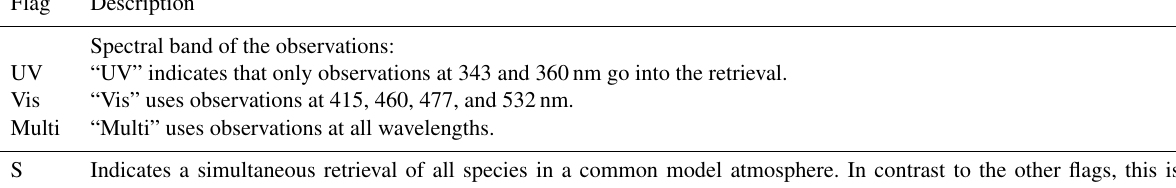
Table 5. Overview of measurement-mode labels. Flag Description Spectral band of the observations: UV “UV” indicates that only observations at 343 and 360nm go into the retrieval. Vis “Vis” uses observations at 415, 460, 477, and 532nm. Multi “Multi” uses observations at all wavelengths.